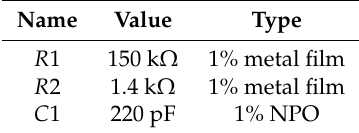
Table 1. Component values for the output voltage conditioning